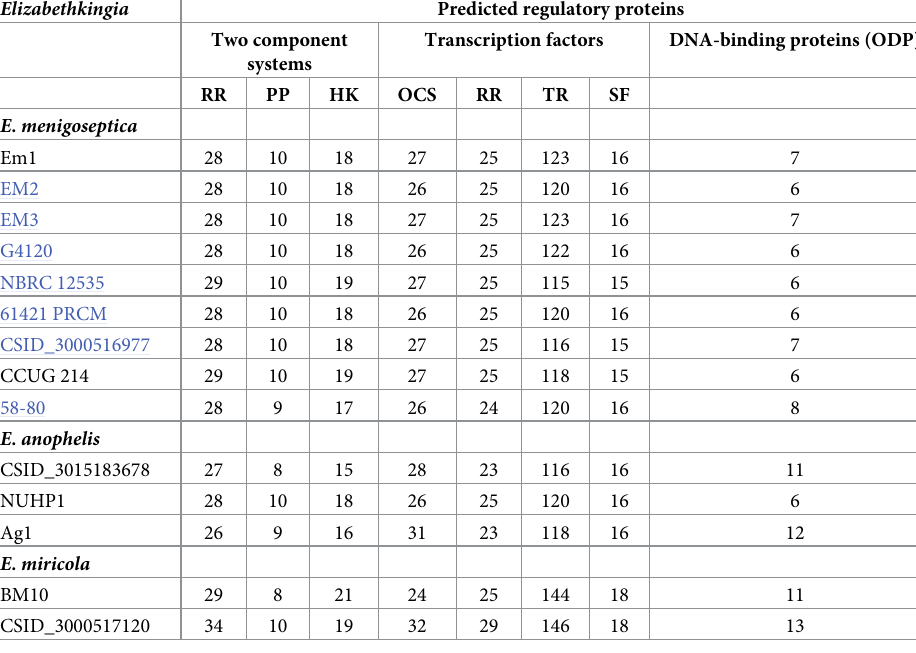
� RR, response regulators; PP, phosphotransferase proteins; HK, histidine kinases; OCS, one-component systems; TR, transcriptional regulators; SF, sigma factors; ODP, other DNA-binding proteins. The numbers in this table are the gene copies encoding the regulatory